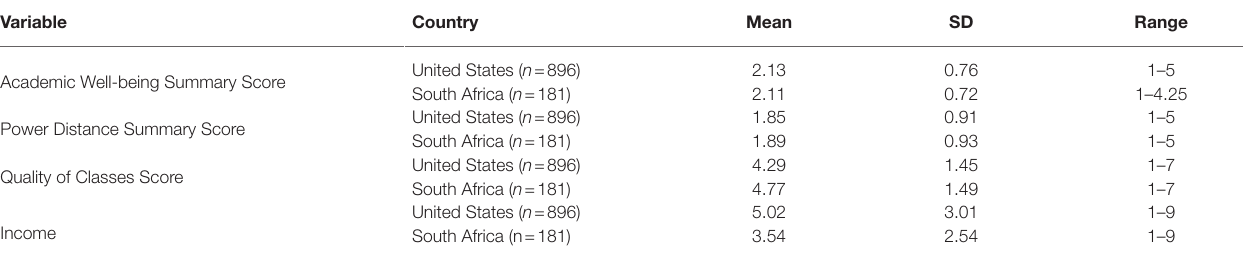
TABLE 1 | Mean, standard deviation, and range for summary scores between